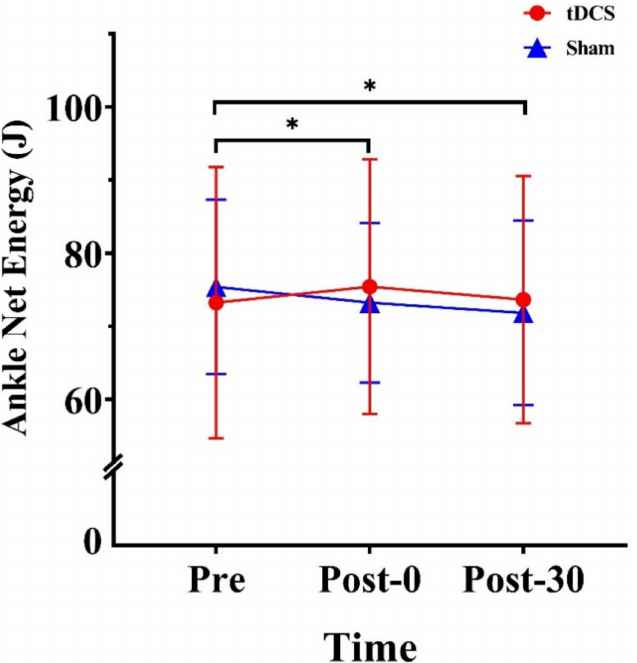
Figure 5. Effects of tDCS on ankle net energy in CMJs. * indicates a significant difference between times. Pre: pre-stimulation, Post-0: post-0 min, Post-30:post-30 min.